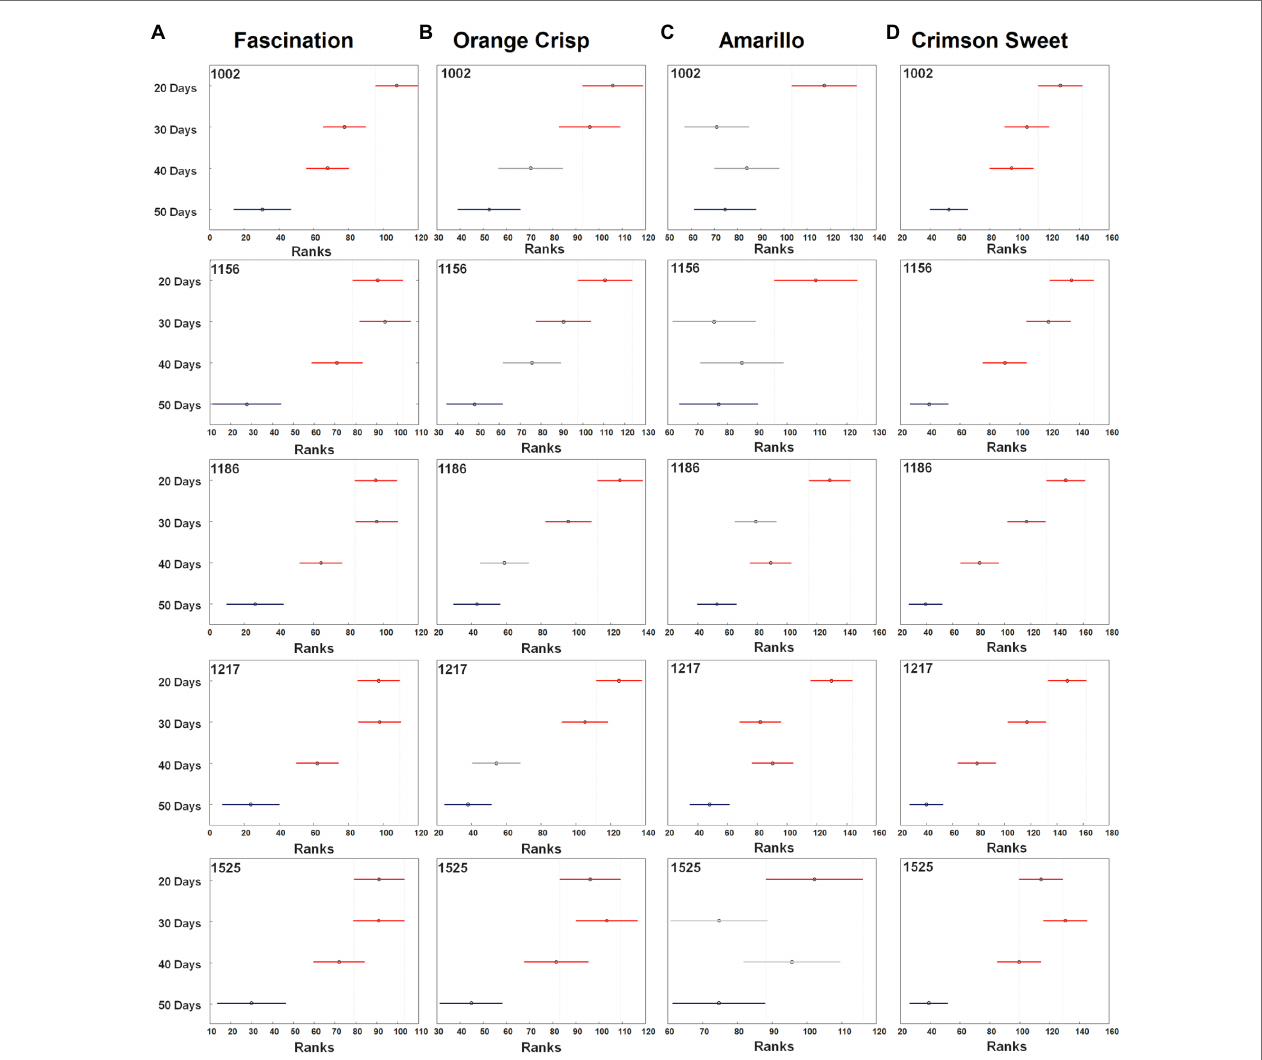
FIGURE 3 | The median (circles) and 95% CI (line) for the relative intensity of bands of carotenoids observed on the surfaces of four watermelon cultivars [Fascination (A) , Orange Crisp (B) , Amarillo (C) , and Crimson Sweet (D) ] at four stages of fruit development. For each stage, 20–43 spectra were collected for each cultivar. The confidence intervals were compared to 50 days stage (blue). The separation of different developmental stages is in red and unseparated is in grey. All the spectra analyzed in Kruskal–Wallis test were normalized to 1,439 cm − 1